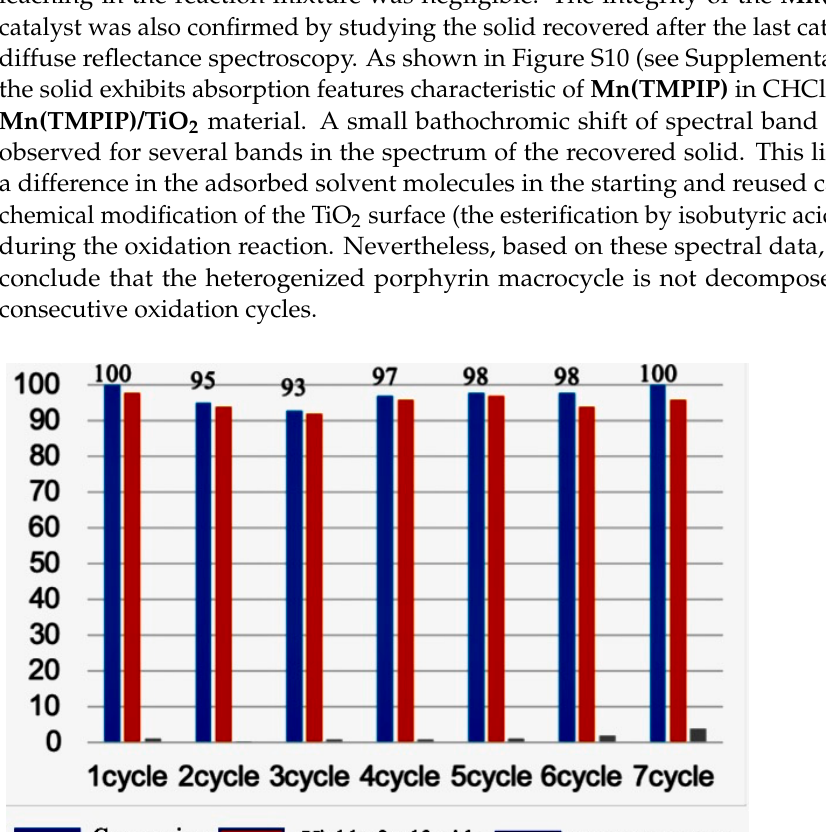
drated TiO 2 [113] also participated in the oxidation.